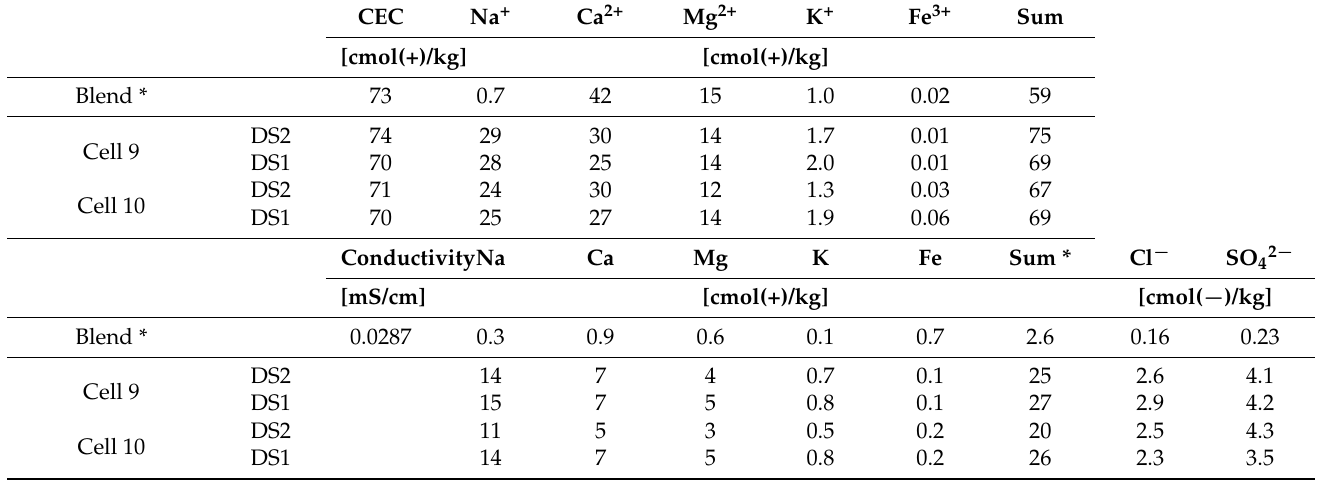
Table 7. CEC, exchangeable cations, electric conductivity of supernatant suspension and soluble cations and anions (granular material HTV-6